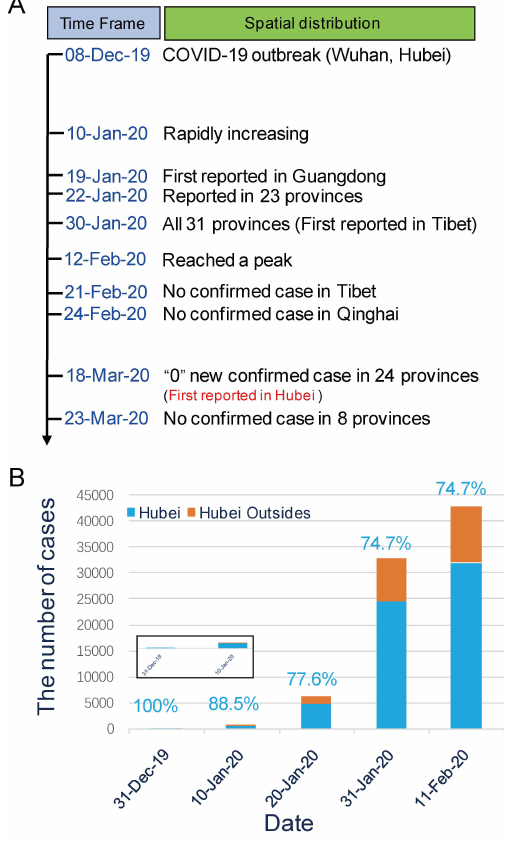
Figure 4. Spatiotemporal distribution of COVID-19. ( A ) The spread and decline of COVID-19 in mainland China over time. The time point (red words) of “0” new confirmed case first reported in Hubei Province was 18 March, 2020. ( B ) Distribution of cases with di ff erent onset times before 11 February